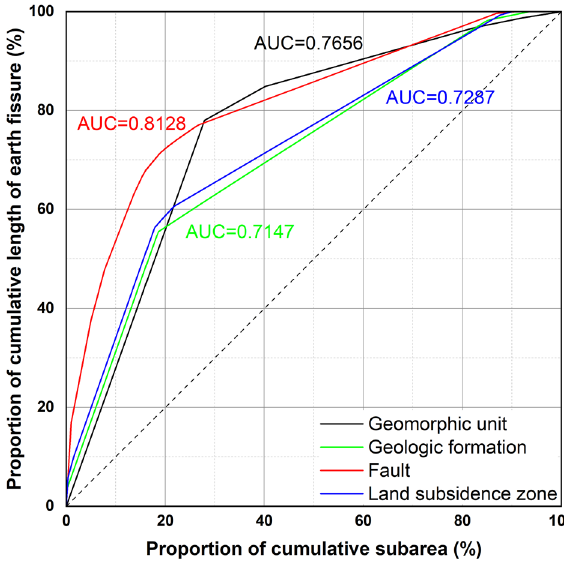
Figure 4. Area under the curve plots for comparing the factors.